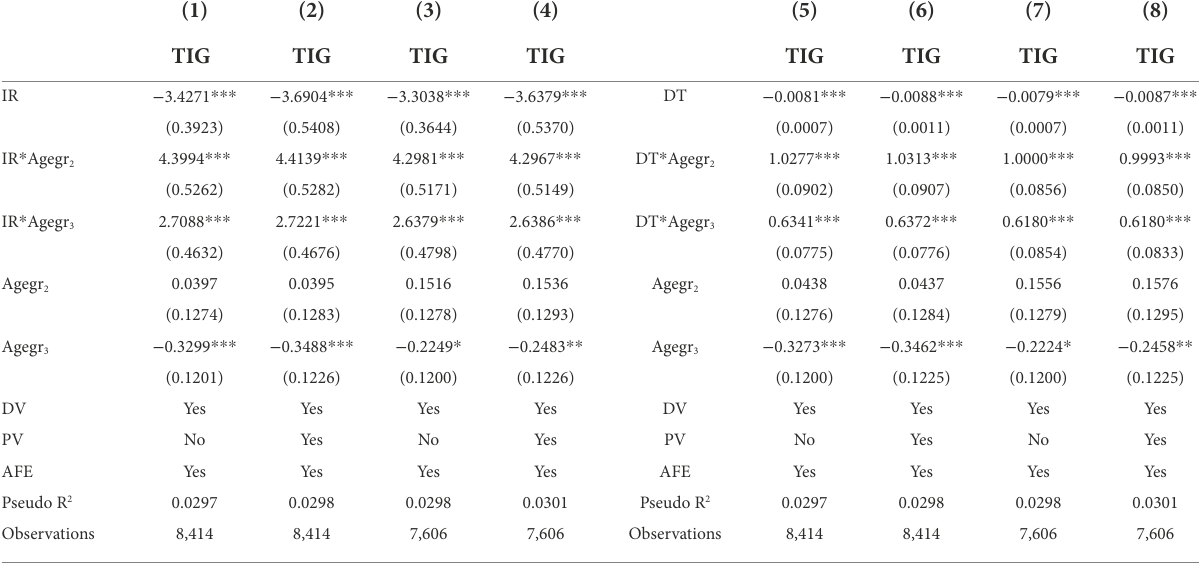
TABLE 8 Robustness test: Changing explanatory